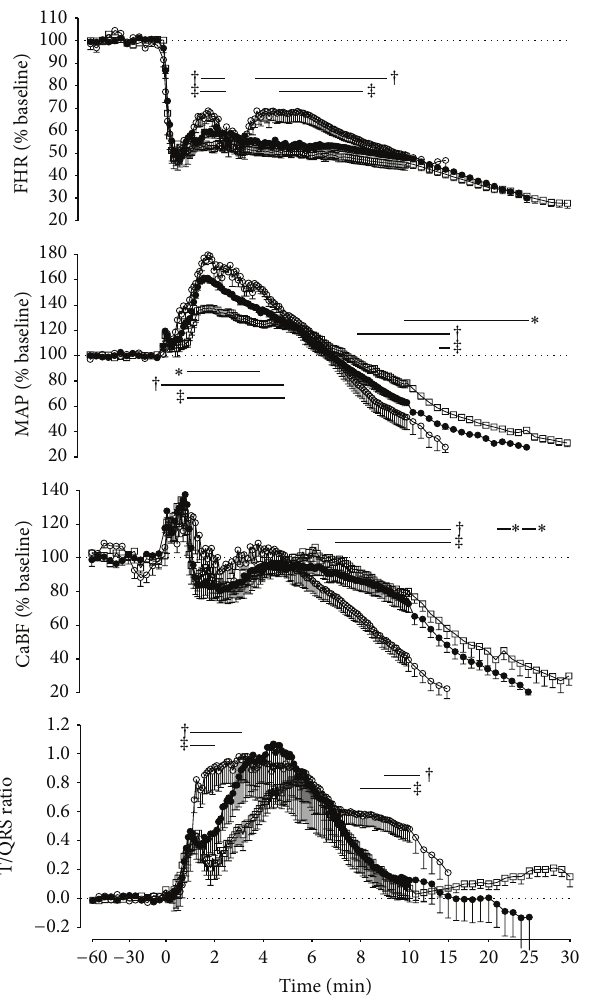
Figure 2: Changes in fetal heart rate (FHR, % baseline), mean arterial pressure (MAP, % baseline), carotid blood flow (CaBF, % baseline), and T/QRS ratio in 0.6 gestation (0.6GA; ⬞ ), 0.7 gestation (0.7 GA; ∙ ), and 0.8 gestation (0.8 GA; ∘ ) fetuses during prolonged umbilical cord occlusion. Data are 5 min averages before occlusion, 5 sec averages during the first 10 minutes of occlusion, and 1min averages for all other occlusion time points, expressed as percentage of baseline. The period of umbilical cord occlusion for each group begins at 0 min and ends at 15min (0.8GA), 25 min (0.7 GA), and 30 min(0.6GA),respectively.Dataaremean ± SEM;between-group comparisons by repeated measures ANOVA and LSD test. ∗ 𝑃 < 0.05 ; 0.6GA versus 0.7 GA, † 𝑃 < 0.05 ; 0.6 GA versus 0.8 GA, ‡ 𝑃 < 0.05 ; 0.7 GA versus 0.8 GA.